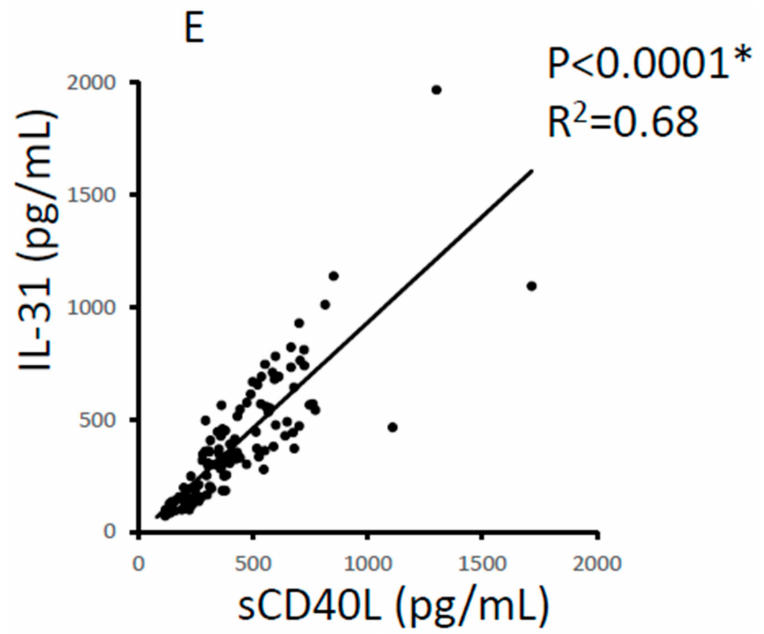
Figure 2. Relationship among serum sCD40L/IL-31, proteinuria (UPCR), and the renal function (eGFR) in IgA nephropathy patients. Serum sCD40L was significantly associated with a lower UPCR ( A ) and higher eGFR ( B ). Similar relations were found between IL-31 and the UPCR ( C ), and eGFR ( D ). Serum sCD40L was highly correlated with IL-31 ( E ). eGFR, estimated glomerular filtration rate; IL-31, interleukin 31; sCD40L, soluble CD40 ligand; UPCR, urinary protein to creatinine ratio. * p <